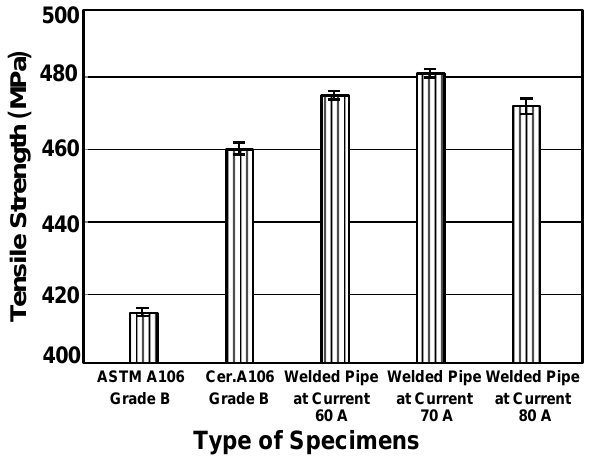
Figure 3. The ultimate tensile strength of ASTM A106 grade B pipe, certified A106 grade B pipe, and welded pipes from various currents at 60, 70 and 80 A.